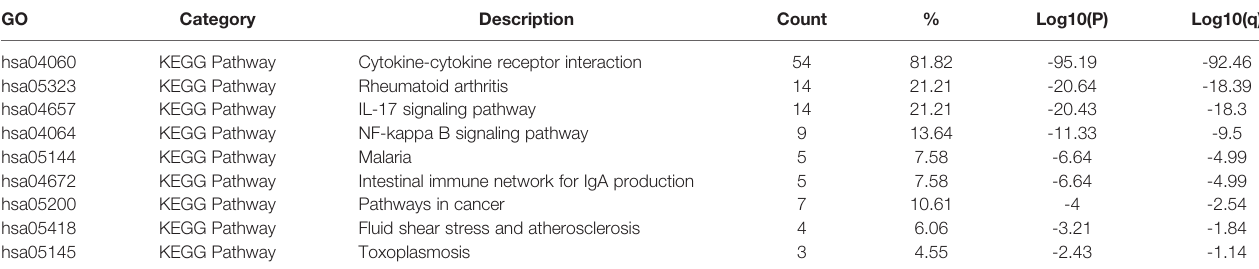
TABLE 3 | The KEGG function enrichment analysis of CXC-chemokines and neighbor genes in HNSCC (Metascape).